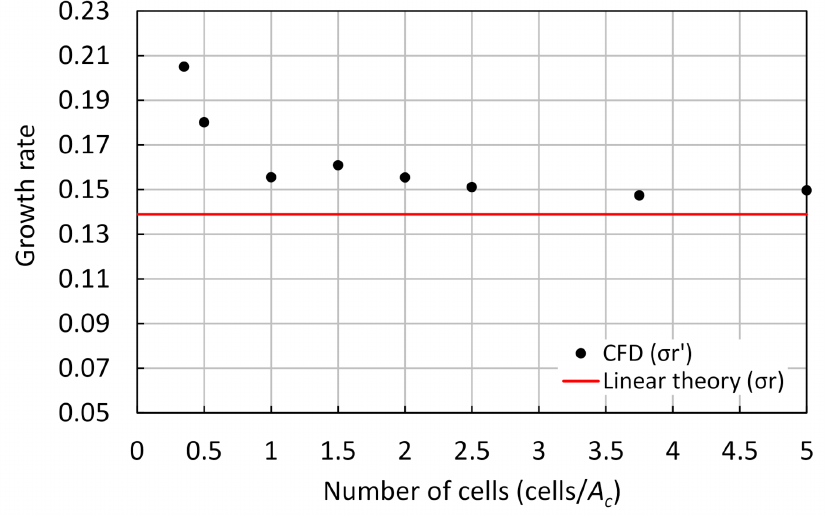
Figure 7. Effect of the growth rate on the number of cells, for C α = 0 and We g =